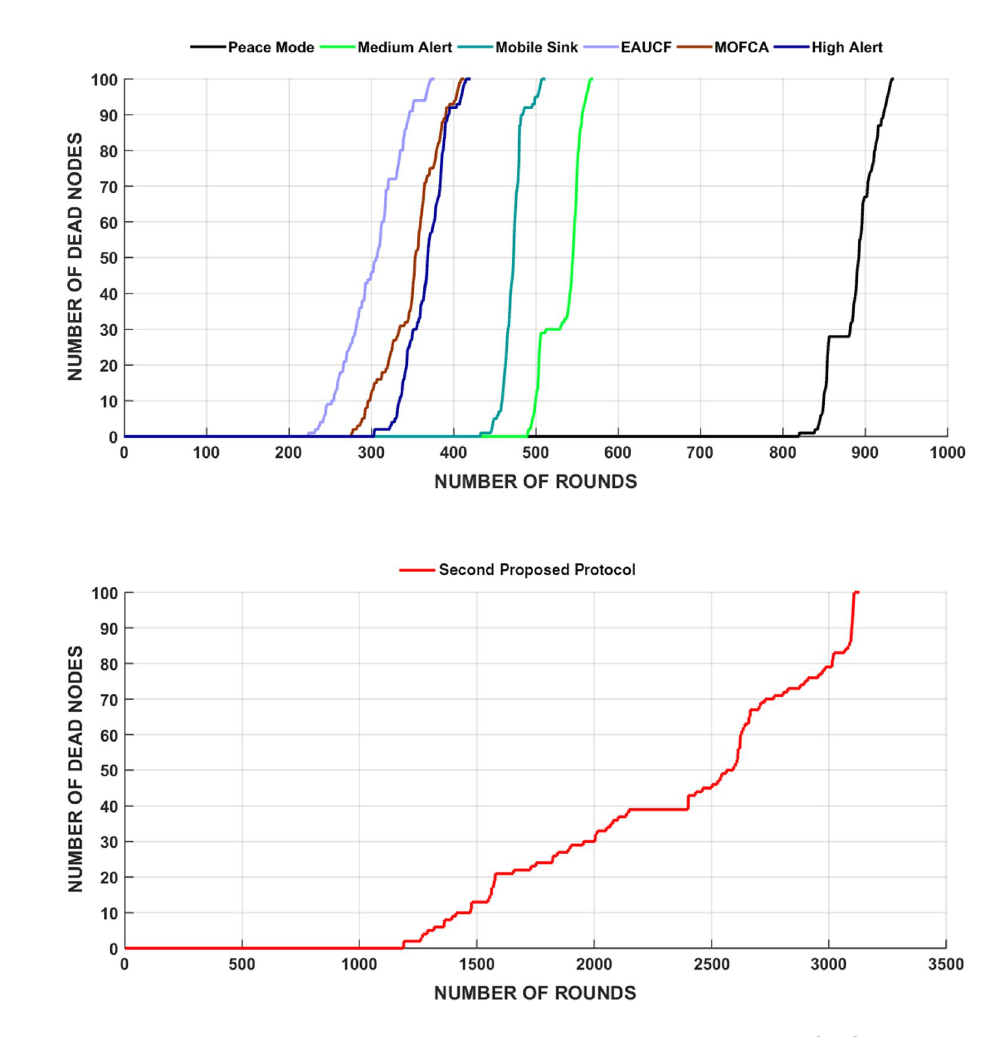
Fig. 9 Ratio of the number of dead nodes to the number of